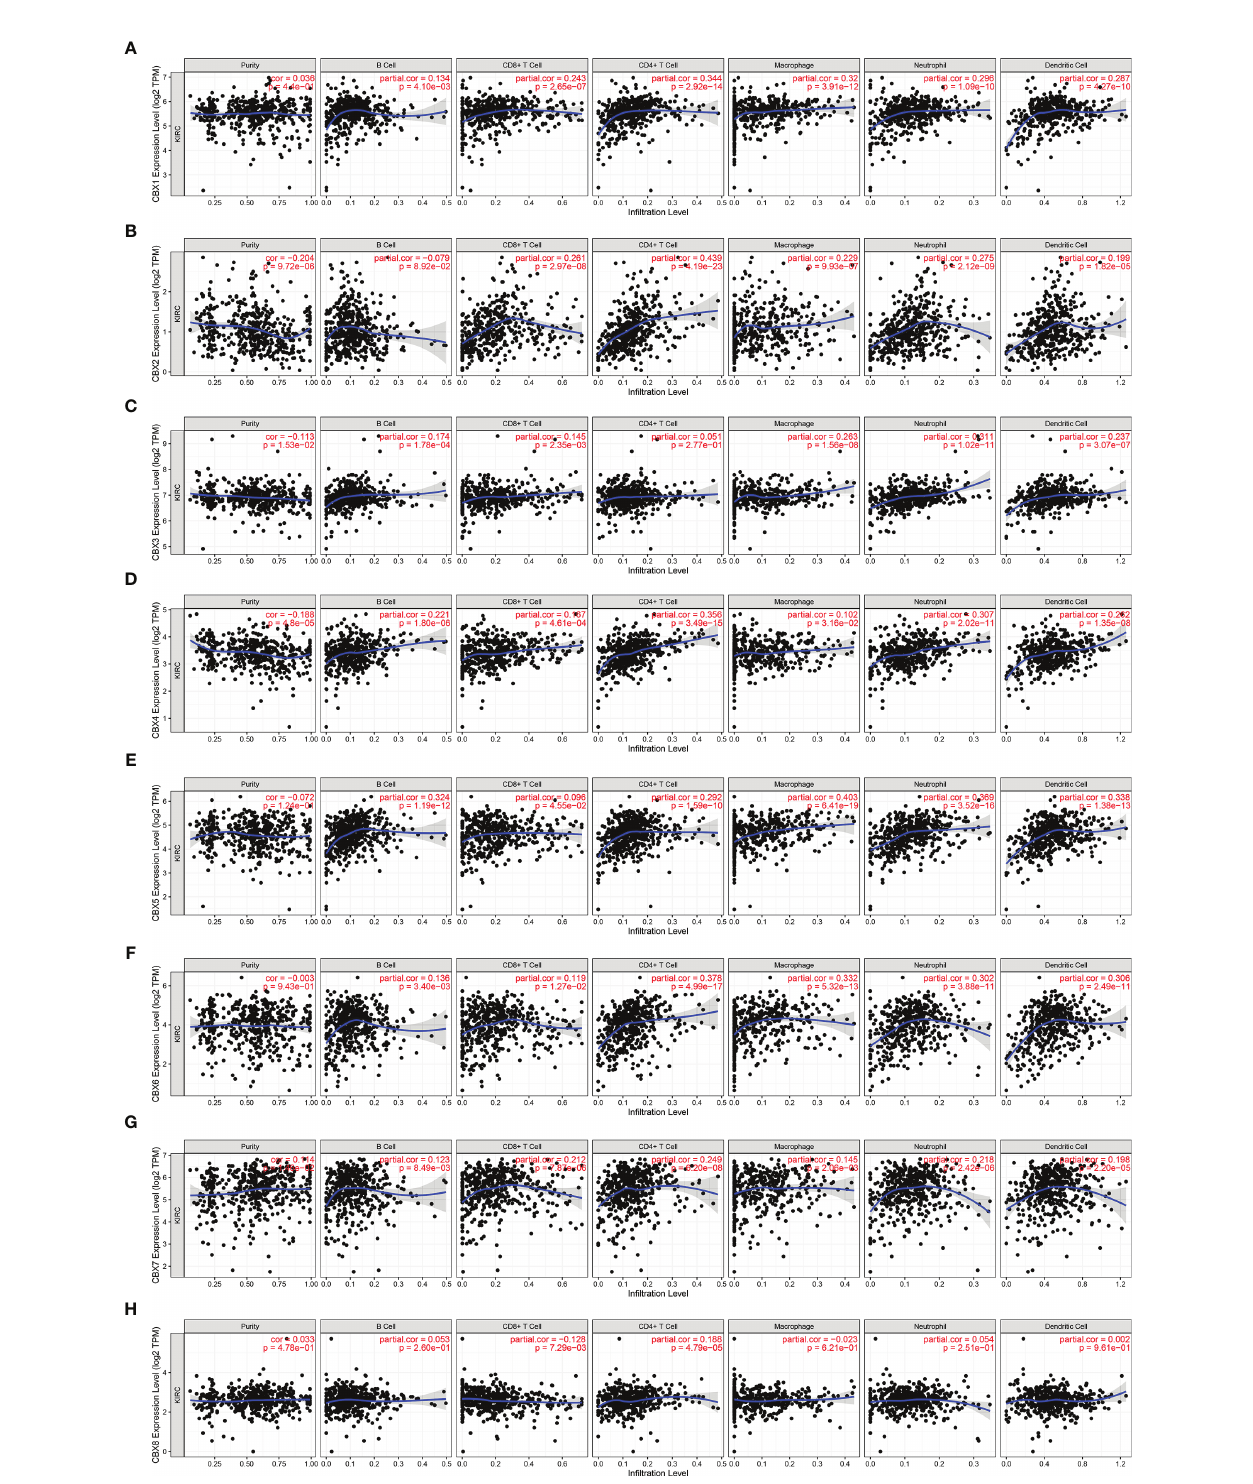
FIGURE 13 | The correlation between differentially expressed CBXs and immune cells in fi ltration (TIMER). CBX1, CBX2, CBX4, CBX5, CBX6 and CBX7 expression was positively correlated with the in fi ltration of B cell, CD8+ T cells, CD4+ T cells, macrophage, neutrophils and dendritic cells (A, B, D – G) . And there was a positive correlation between CBX3 expression and the in fi ltration of B cell, CD8+ T cells, macrophage, neutrophils and dendritic cells (C) . The expression of CBX8 was positively associated with the in fi ltration of CD4+ T cells, and negatively associated with the in fi ltration of CD8+ T cells (H)